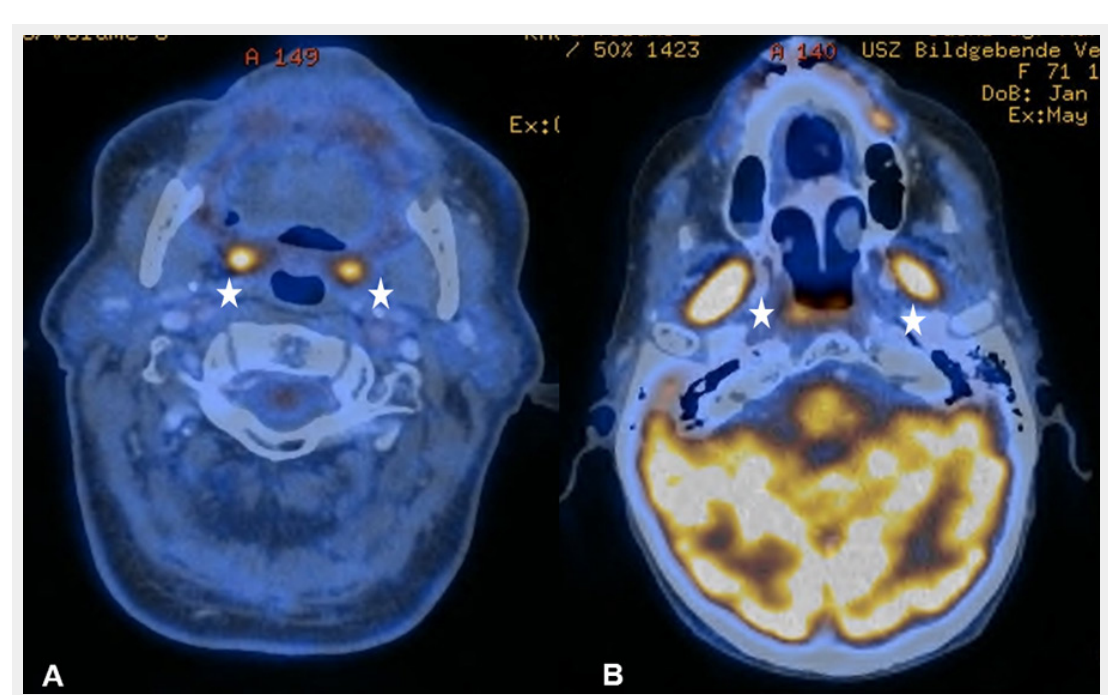
(A) Bilateral physiological uptake in the palatine tonsils in a 83-year old patient with a past medical history of a floor of nose melanoma. (B) Symmetric increased uptake in the muscles of mastication in 71-year old patient treated for tonsillar carcinoma.